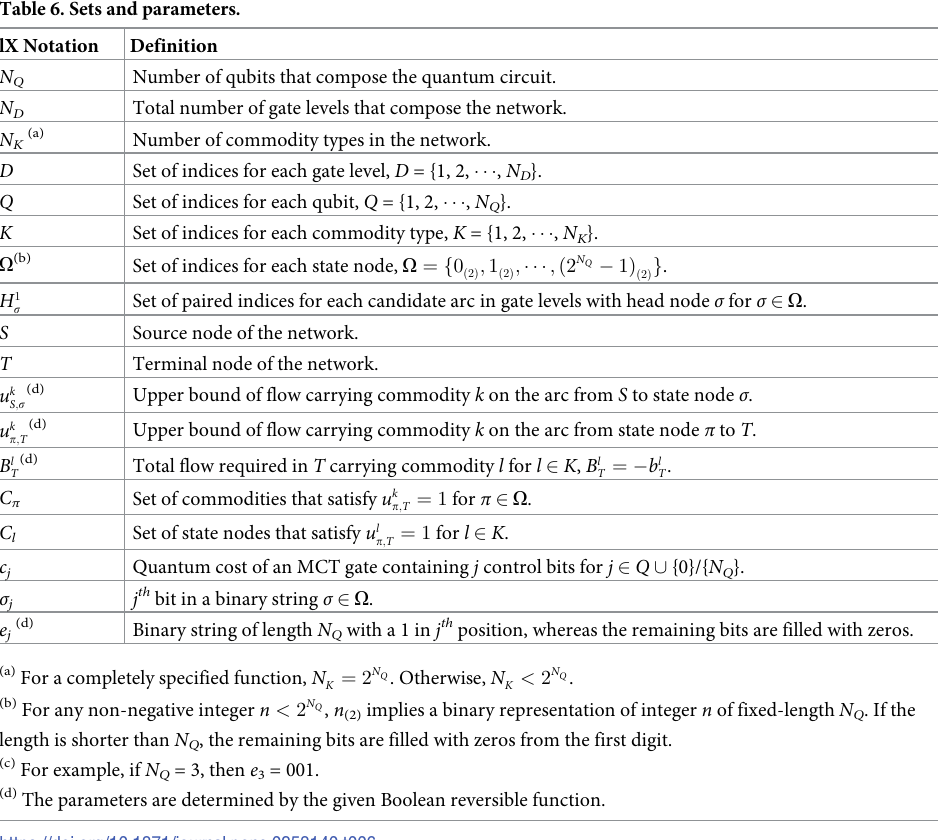
Table 6. Sets and